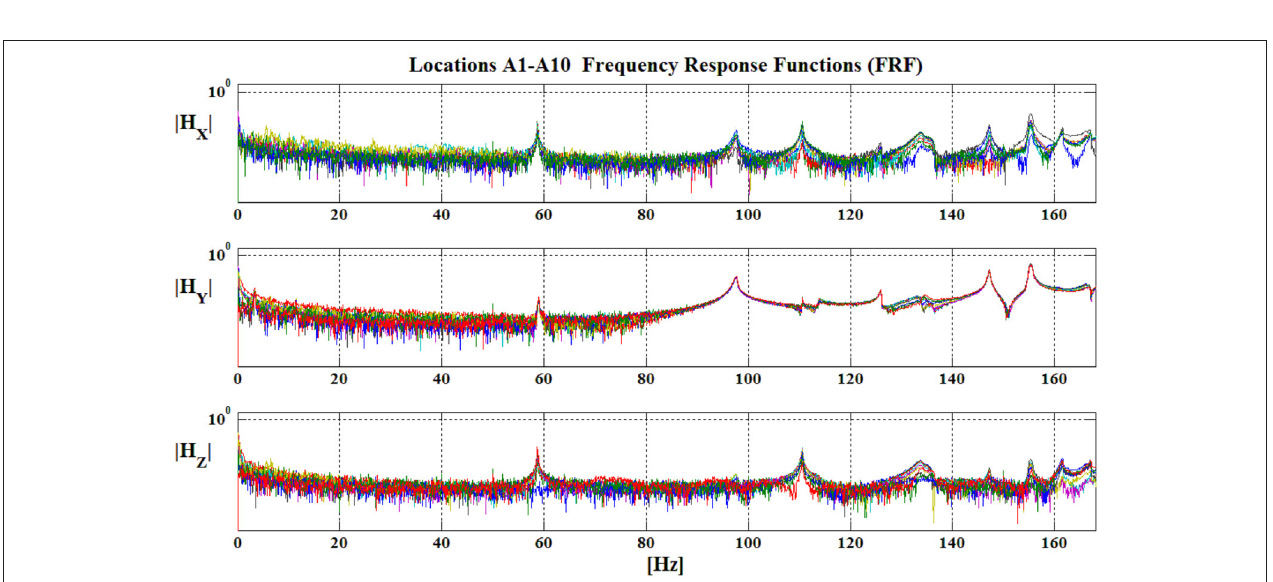
FIGURE 8 | Typical elements of the experimental FRF matrix for the intermediate pressure rotor.